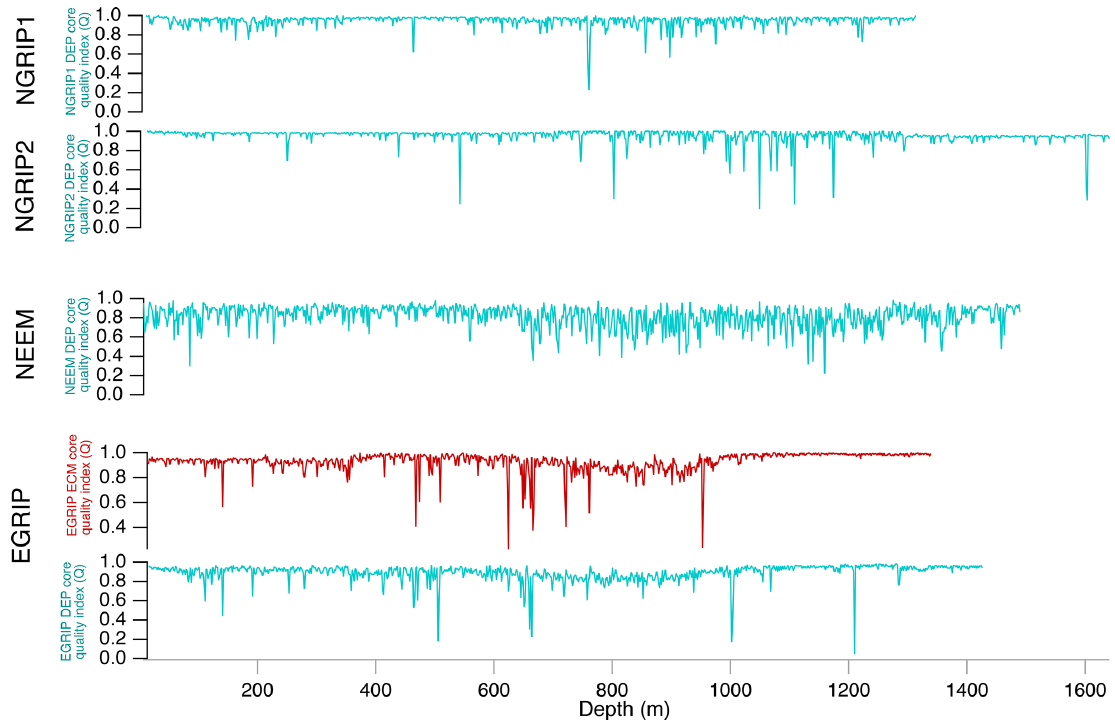
Figure A1. Quality indices for the EGRIP, NGRIP and NEEM ice cores.